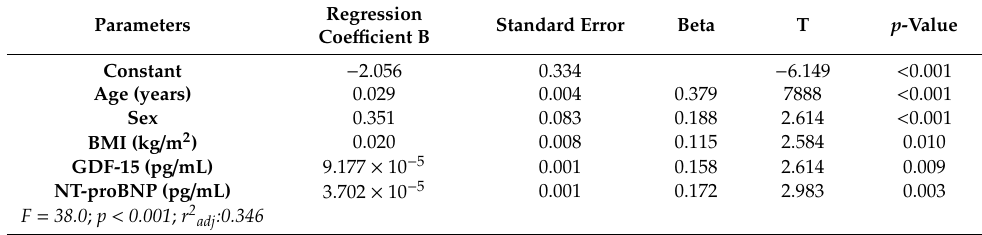
Table 2. Multiple logistic regression analysis for ejection fraction.